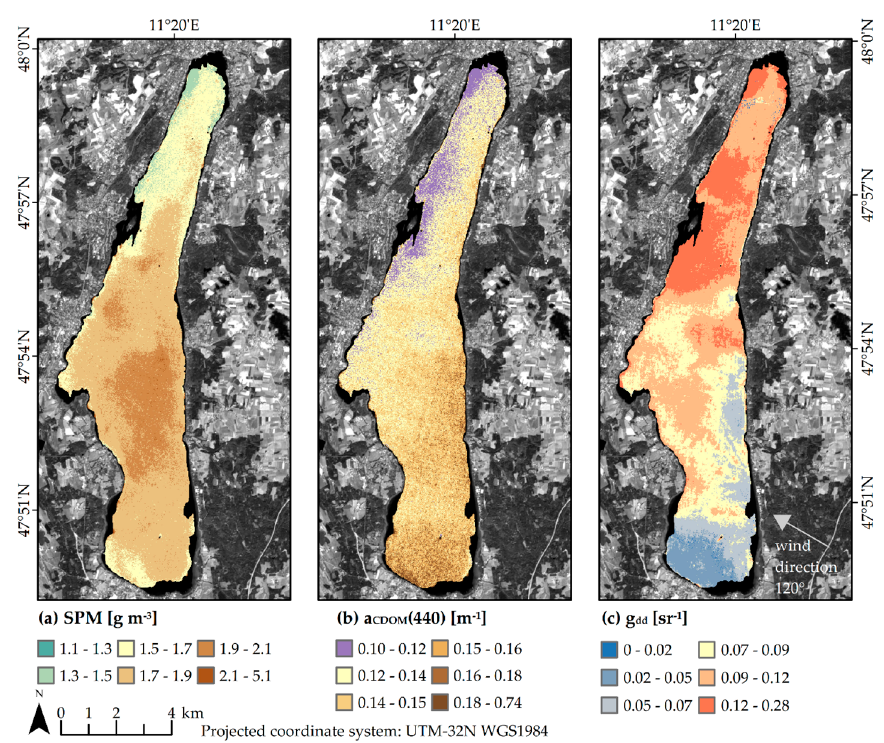
Figure 6 . Results of deep water inversion using the MIP 20 m pixel size dataset. Background is gray scaled S2-A band B05 (705 nm).